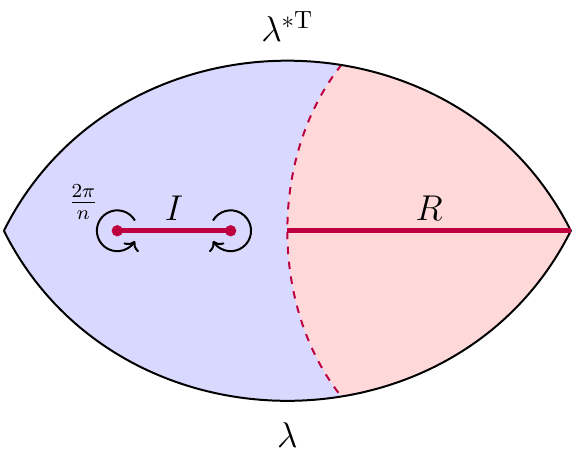
Figure 7. After quotienting by the Z n replica symmetry, we get a manifold M n with a single copy of the boundary conditions. There is a conical defect at Υ = ∂I , and we insert twist operators on I ∪ R